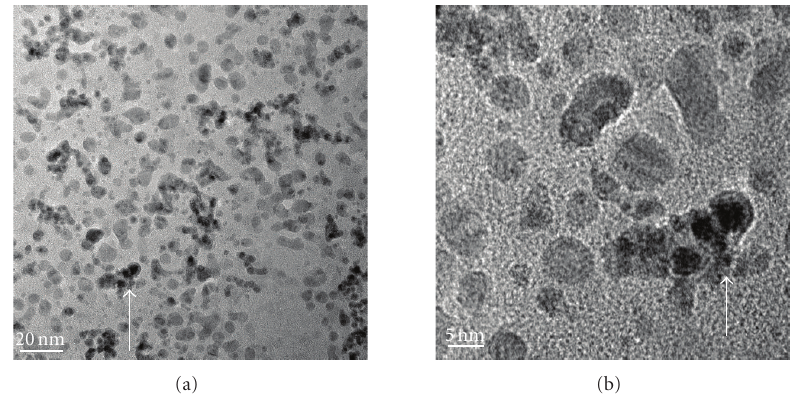
Figure 1: TEM (a) and HRTEM (b) of Pt-Ru nanoparticles in aqueous colloid; the arrows denote the same